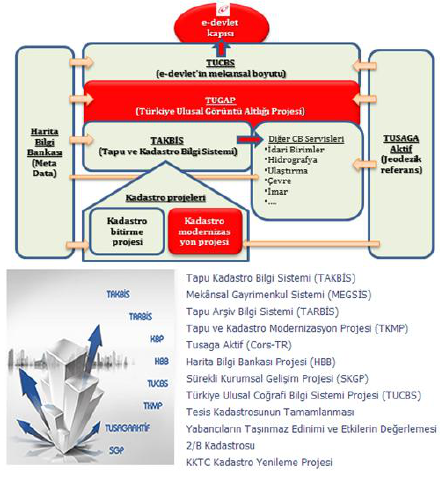
Figure 1. Projects of GDLRC